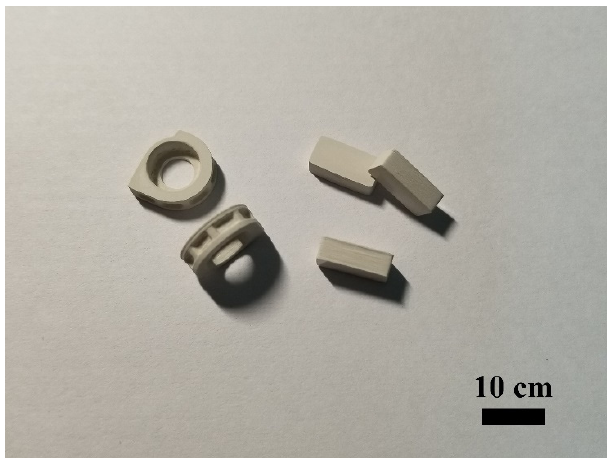
Figure 8. The stereolithography of Si 3 N 4 ceramic architectures with complex shape and simple cuboid structures.